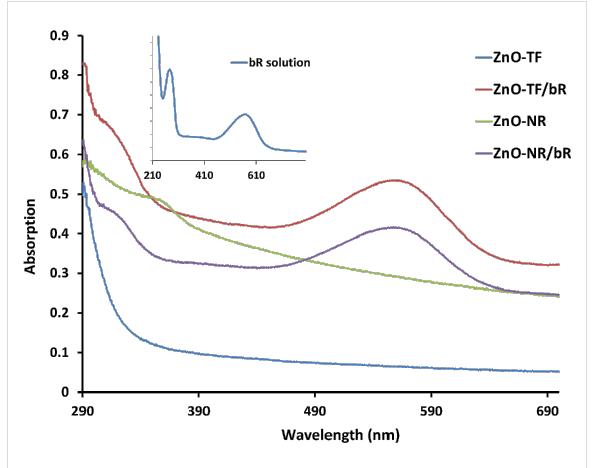
Figure 3: UV–vis spectra of ZnO-TF (blue); ZnO-NR/bR (purple); ZnO-NR (green) and ZnO-TF/bR (red) structures. The absorption spectrum of the bR protein (inset) indicates two specific absorption peaks of photoactive bR protein at 570 nm and 270 nm (in a 1 to 2 in- tensity